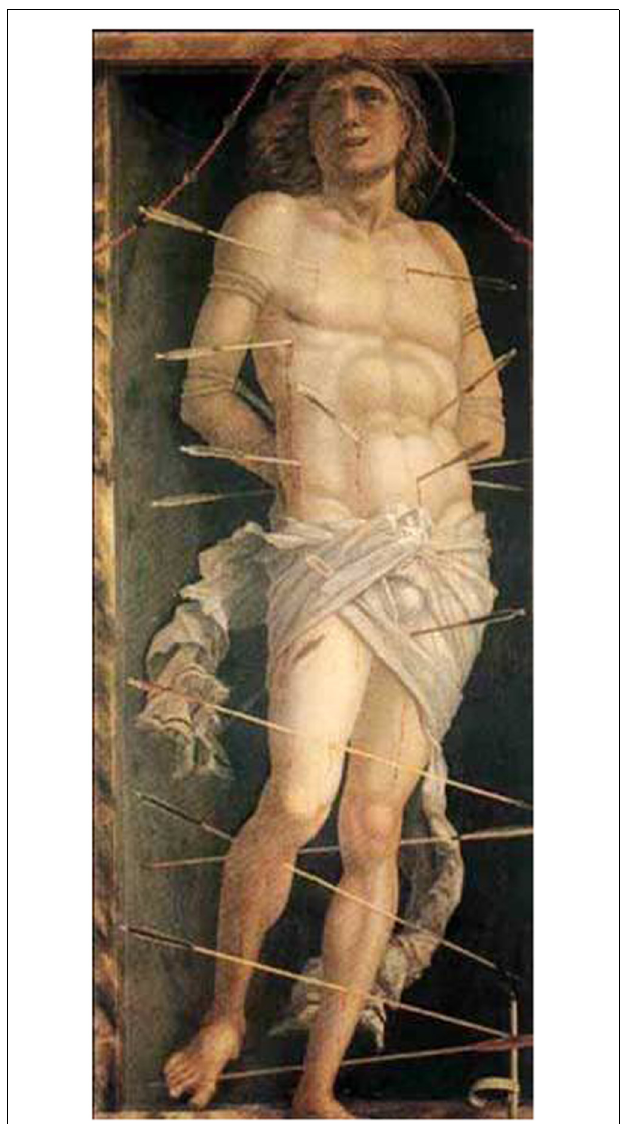
FIGURE 4 |The painting of St Sebastian by Mantegna in the Ca d’Oro museum inVenice. The arrows symbolize a polyclonal antibody response which is not directed to a single vaccine